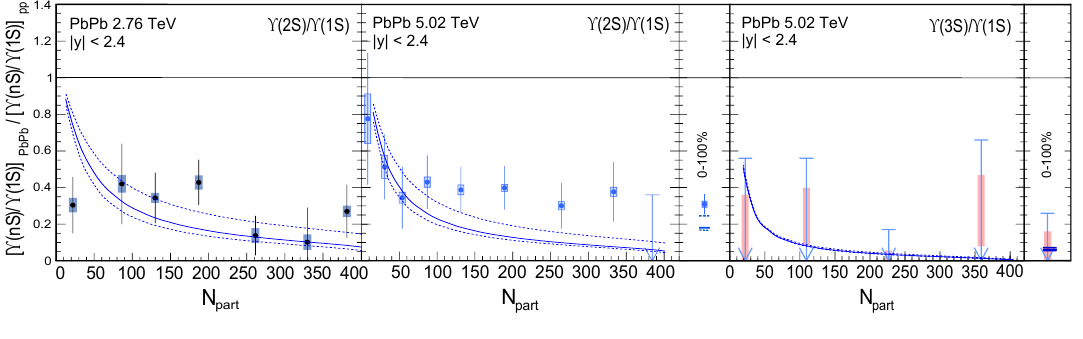
Figure 2 . The double ratio ( R (cid:7)( mS ) = (cid:7)( nS ) ) for (cid:7)(2 S ) over (cid:7)(1 S ) at 2.76 and 5.02 TeV and (cid:7)(3 S ) PbPb over (cid:7)(1 S ) at 5.02 TeV as a function of N part obtained from the CIM with the CMS data at 2.76 TeV [11] and 5.02 TeV [19]. The dashed line depicts the uncertainty from the (cid:12)t of (cid:27) co (cid:0) (cid:7)